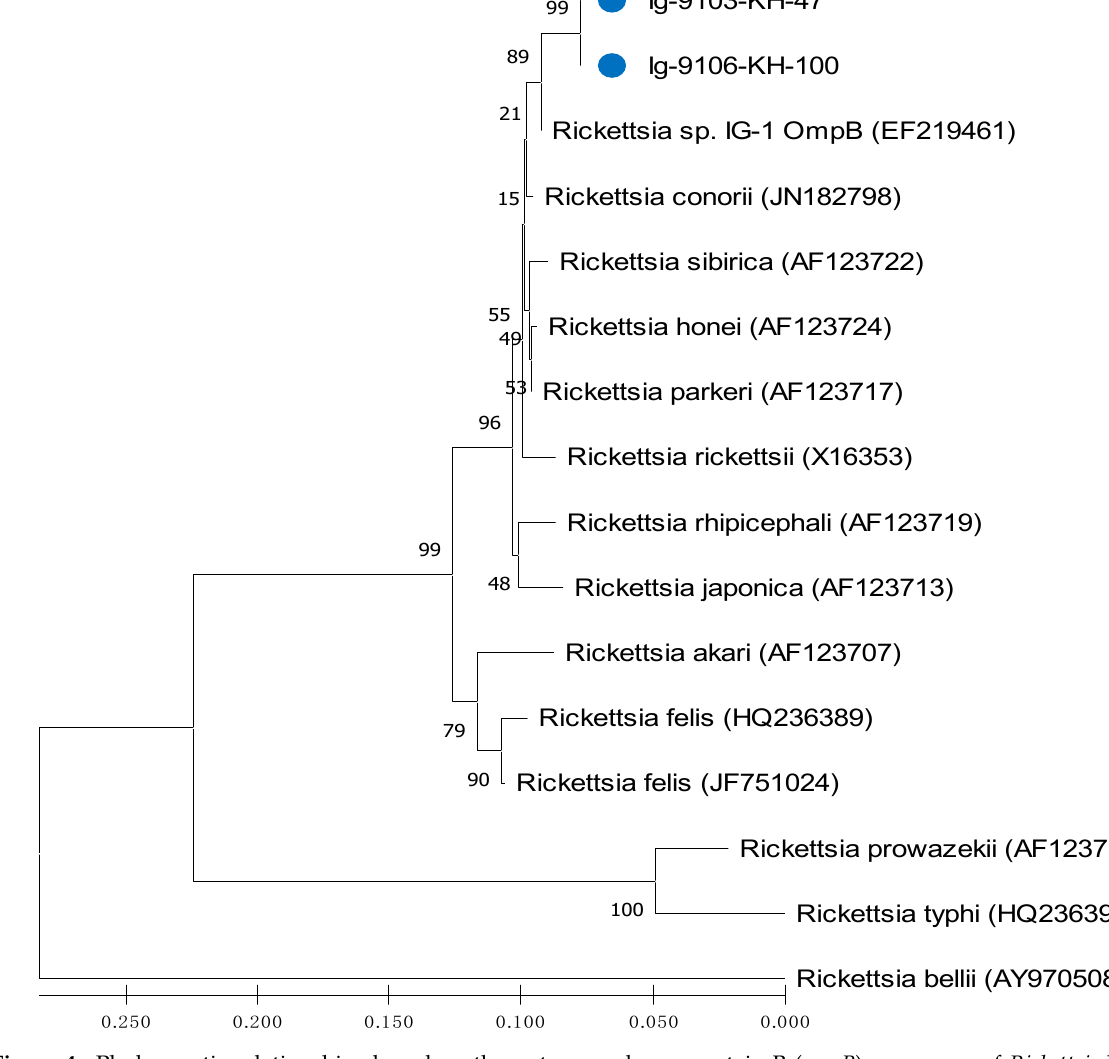
Figure 4. Phylogenetic relationships based on the outer membrane protein B ( ompB ) sequences of Rickettsia between 2 specimens (indicated as • ) collected from Ixodes granulatus ticks of Taiwan and 14 other Rickettsia specimens identified from various biological and geographical origins. The tree was constructed and analyzed by neighbour-joining (NJ) method using 1000 bootstraps replicates. Numbers at the nodes indicate the percentages of reliability of each branch of the tree. Branch length is drawn proportional to the estimated sequence divergence.